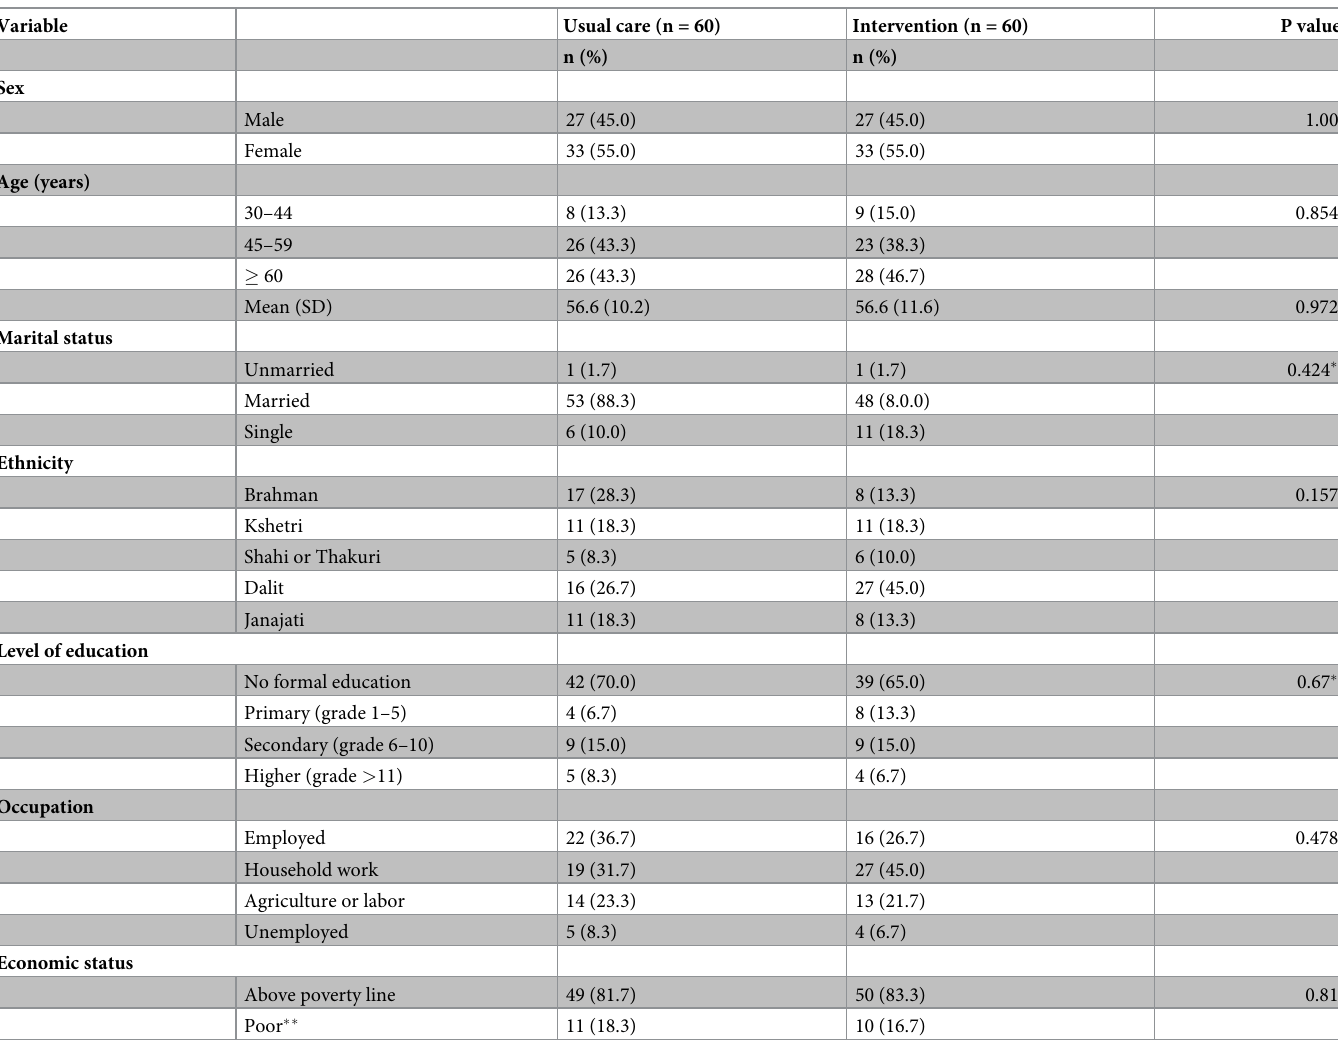
Table 1. Baseline socio-demographic characteristics of study